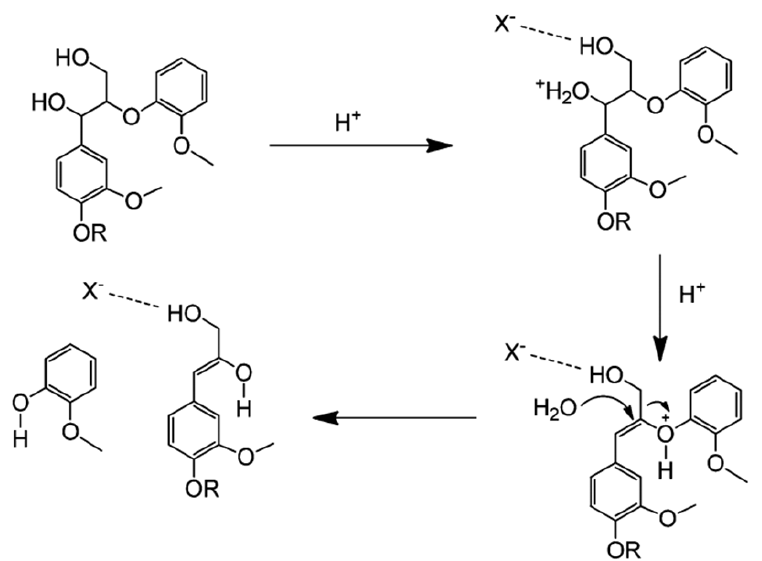
Figure 6. Schematic reaction mechanism of depolymerization of lignin under acidic conditions showing the effect of IL anions; adopted from [170].